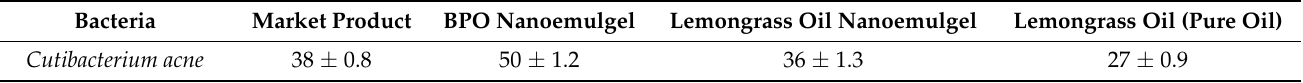
Table 3. The ant-acne activity of BPO nanoemulgel compared with the market